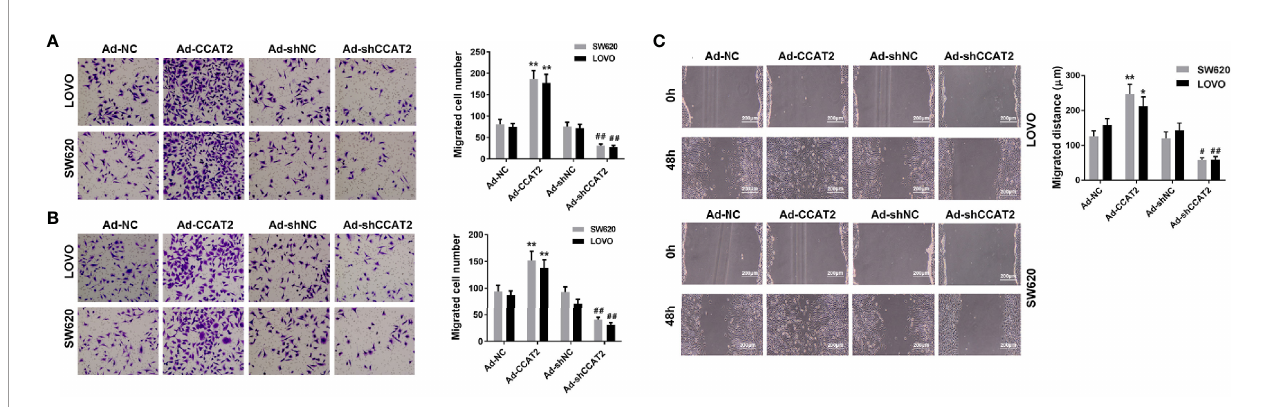
FIGURE 3 | Ectopic expression of CCAT2 promoted colorectal cancer cell migration and invasion. Transwell assay was performed to assess the migration (A) and invasion (B) of CRC cells. CCAT2 promotes cell migration and invasion in SW620 and LOVO cells (×400). (C) Cell migration was further evaluated using wound healing assay. CCAT2 accelerate the healing of SW620 and LOVO cells (×400). The data are represented as mean ± SD. Three independent biological repeats were used for each analysis. *P < 0.05, **P < 0.01 vs Ad-NC, # P < 0.05, ## P < 0.01 vs